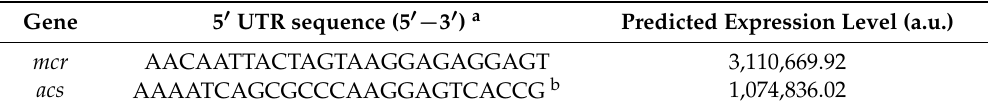
Table 1. Synthetic 5 ′ UTR for gene expression.